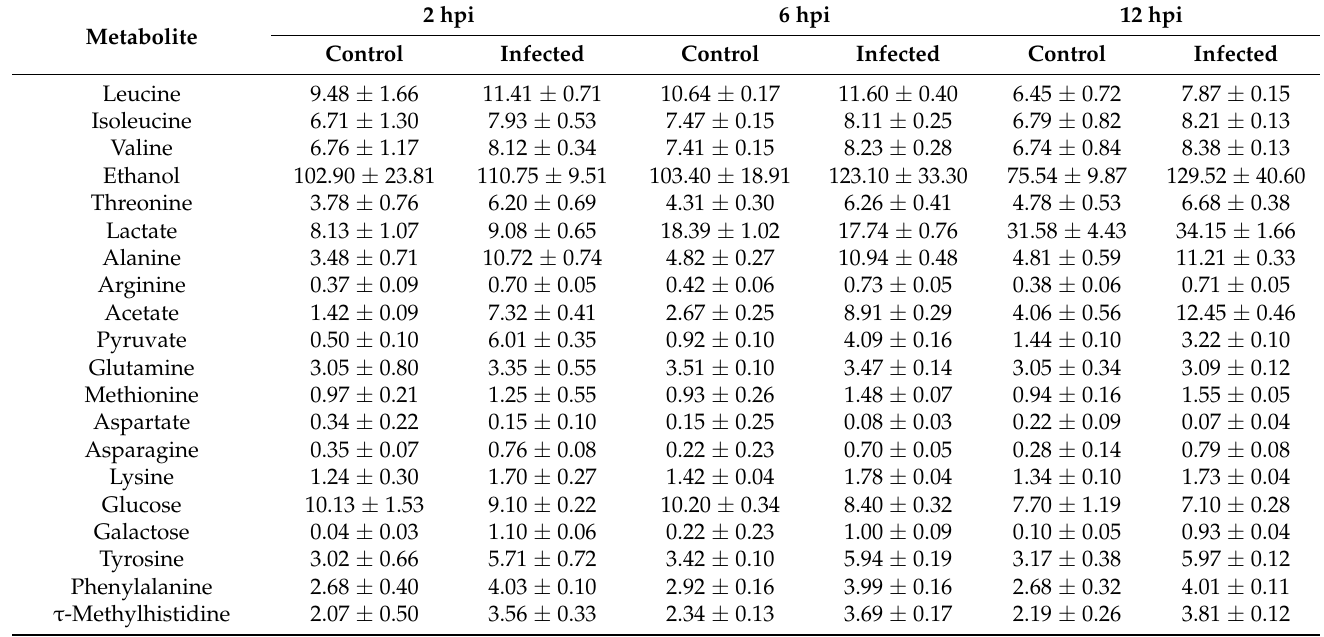
Table 1. Relative metabolite levels as integrals measured for specific